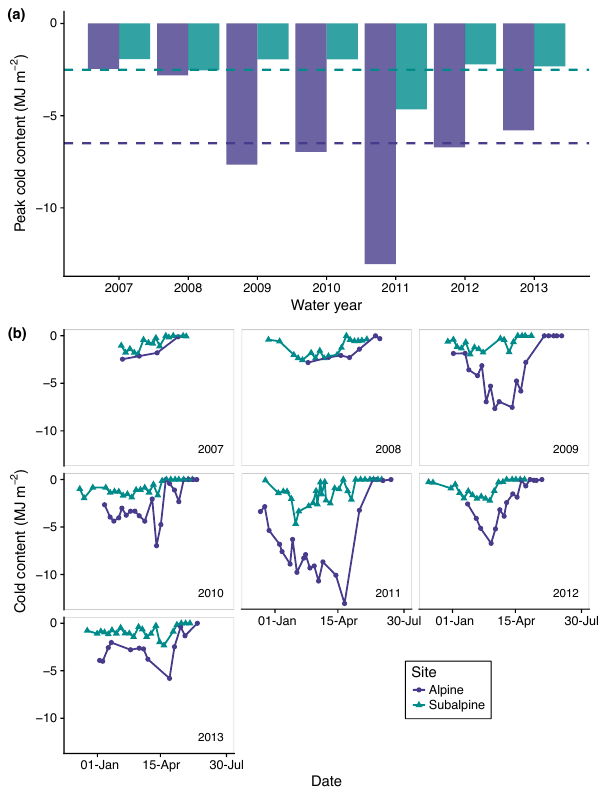
Figure 2. Peak annual cold content (a) and individual snow pit ob- servations of cold content (b) for the alpine and subalpine from WY2007–WY2013. The dashed horizontal lines in (a) represent the mean peak annual cold content values for the two sites.